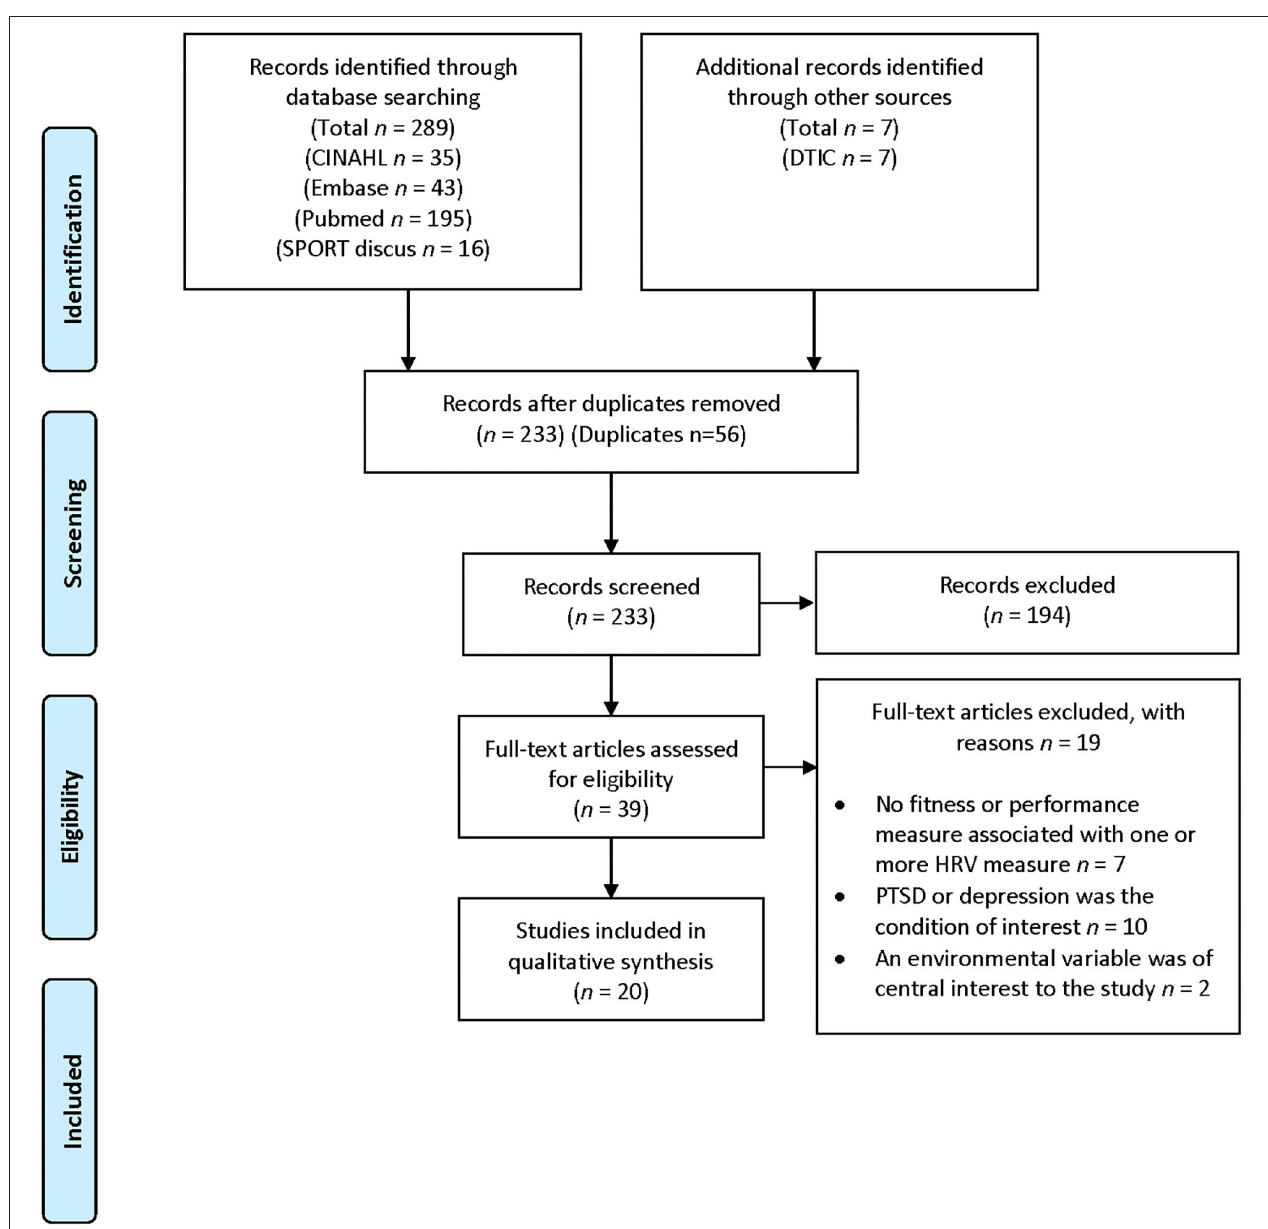
FIGURE 1 | PRISMA flow